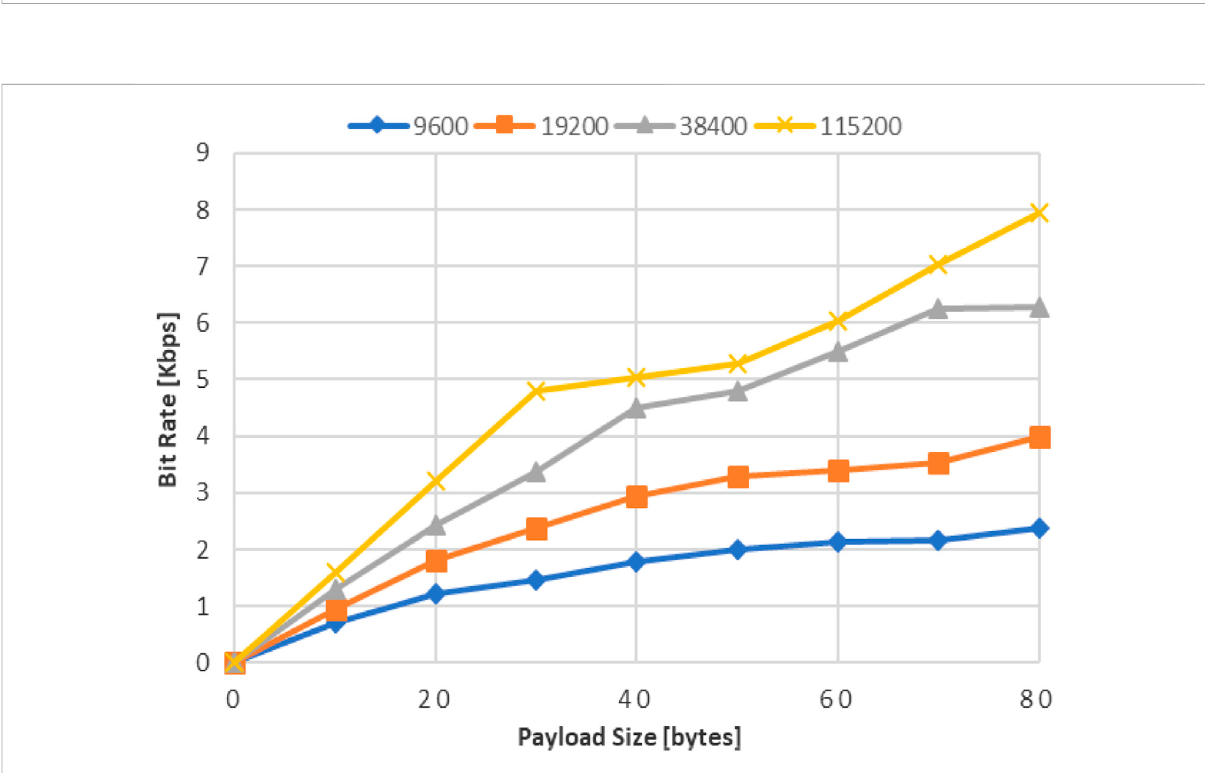
FIGURE 11 ZigBee network